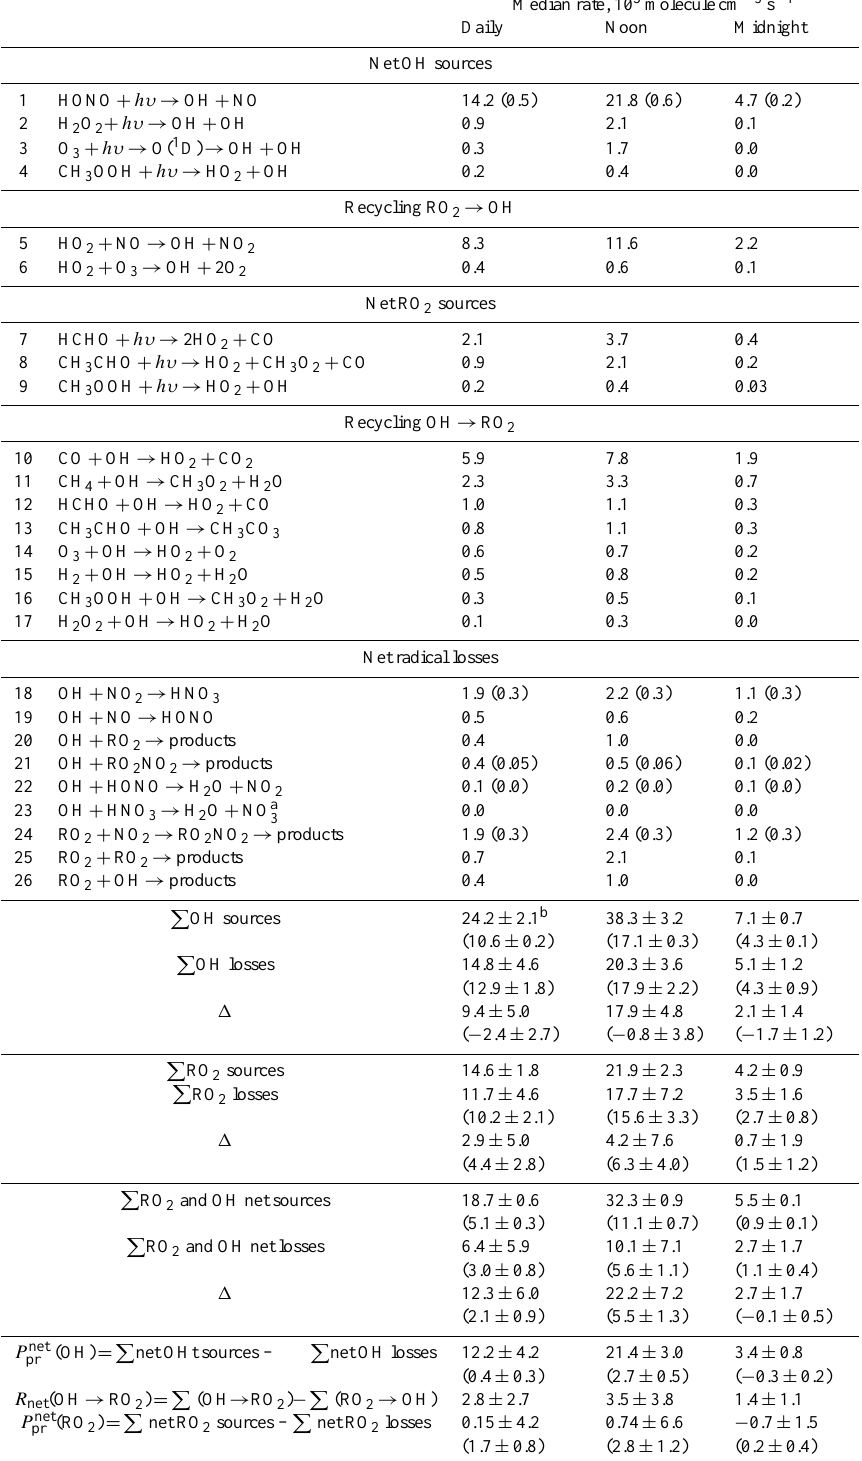
Table 2. Sources and sinks of OH and RO 2 radicals estimated from the measurements available at Dome C ∗